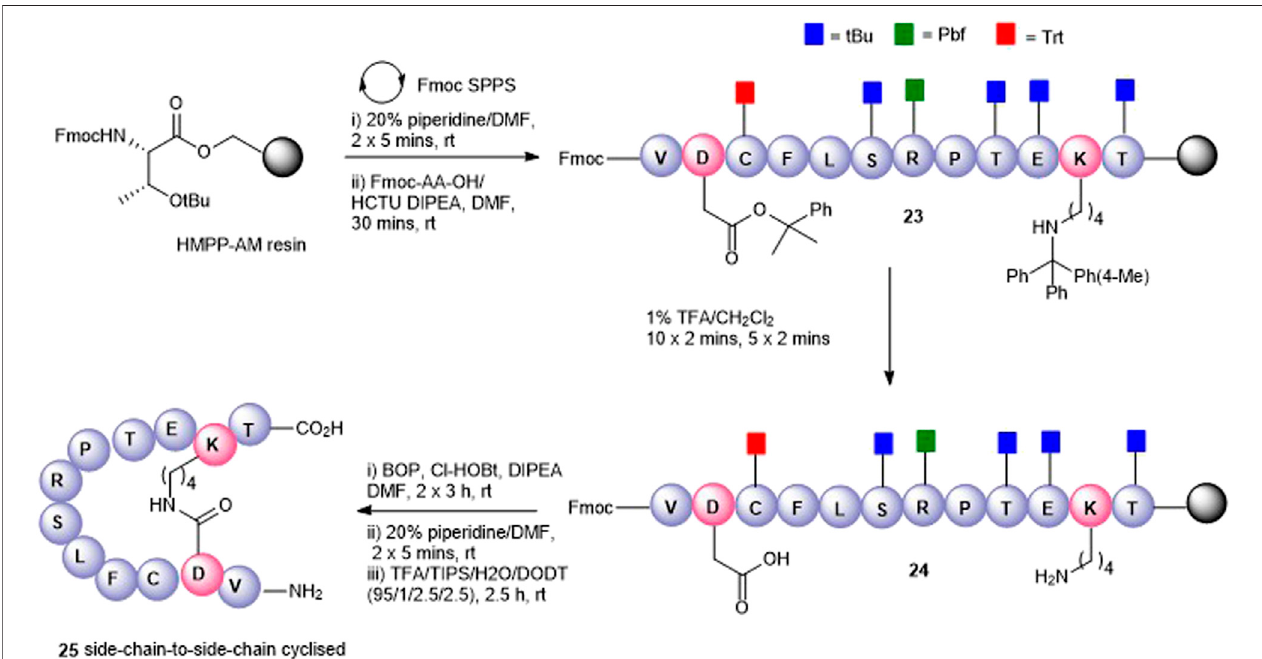
FIGURE 4 | Synthesis of the Asp2-Lys11 side-chain – to – side-chain cyclized peptide5 ( 25 ).